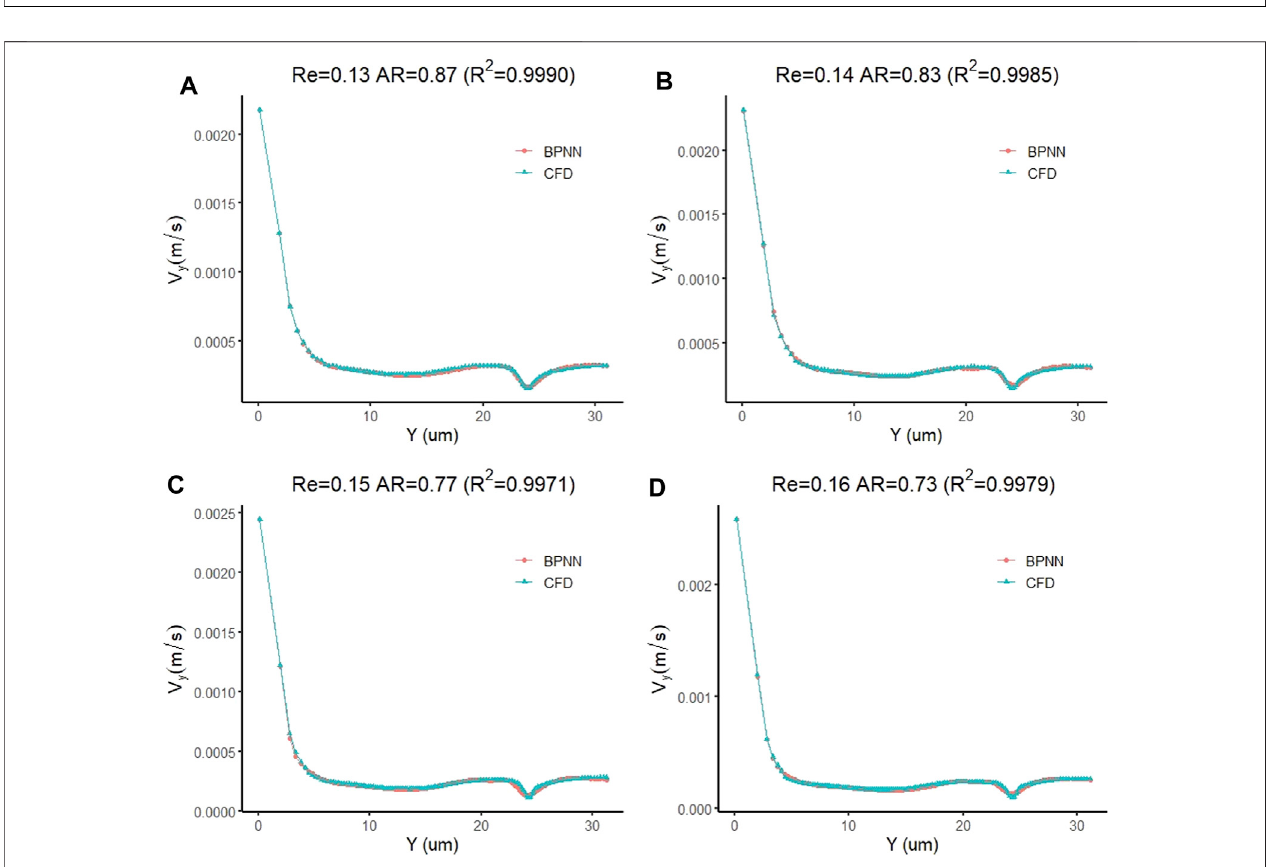
FIGURE 11 | Prediction accuracy test of the leukocyte transmigration prediction model used for cell forward velocity prediction (A) Re = 0.13, AR = 0.87; (B) Re = 0.14, AR = 0.83; (C) Re = 0.15, AR = 0.77; (D) Re = 0.16, AR = 0.73.